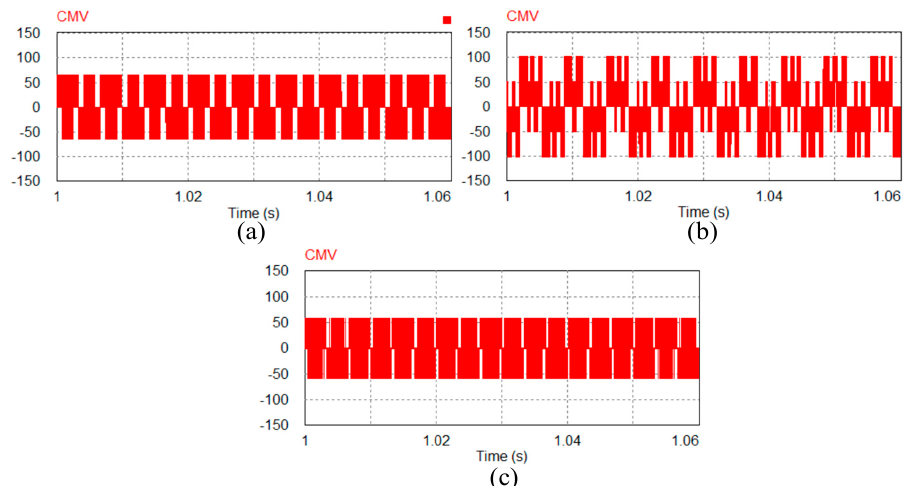
Figure 10. CMV comparison between ( a ) the method in [27], ( b ) the method in [30], and ( c ) the proposed method.